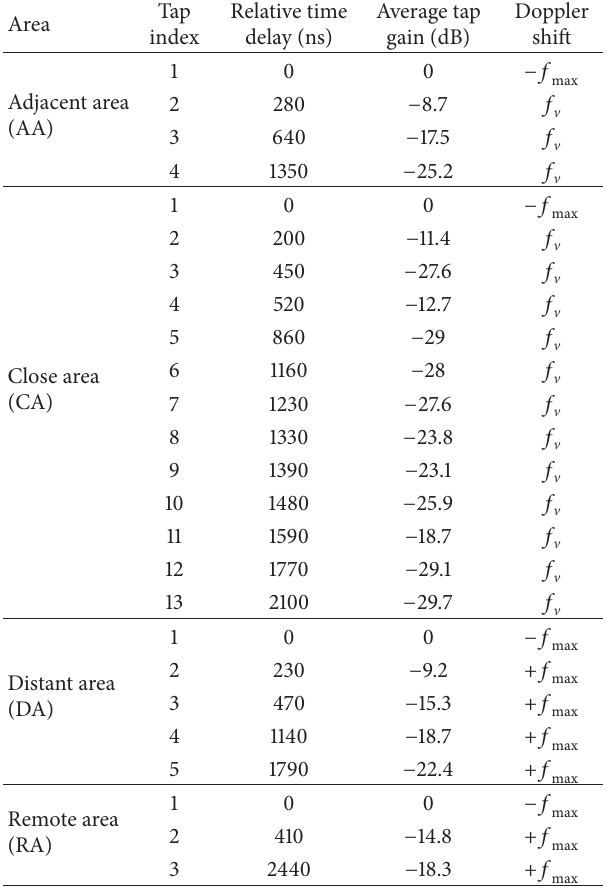
Table 3: TDL model for HSR hilly